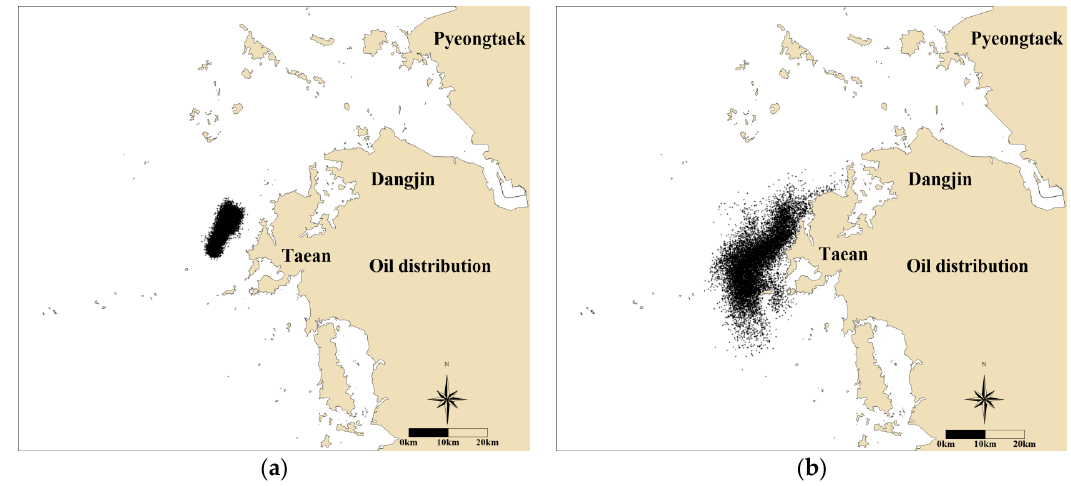
Figure 16. Oil distribution considering tidal current conditions: at 8 p.m., on 7 December 2007, ( a ) 13 h after the accident; ( b ) at 11 a.m., on 11 December 2007.